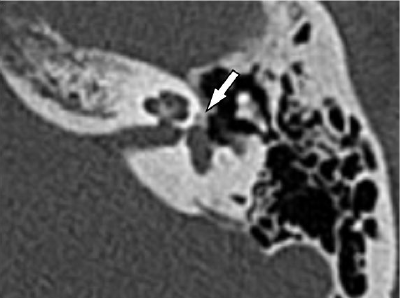
Figure 2. Non-contrast high-resolution temporal bone computed tomography (HRCT) image in the axial plane showing a temporal bone with surgically confirmed otosclerosis. The white arrow indicates a fenestral otosclerotic focus that was detected in the HRCT images by the subspecialist neuroradiologist in the second reading but missed by the general radiologist in the clinical routine reading.